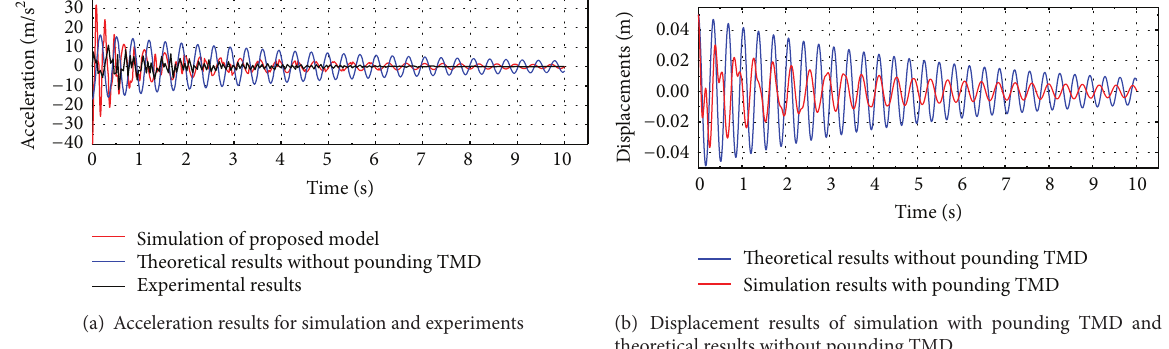
Figure 14: Comparisons of acceleration and displacements for simulation and experiments.